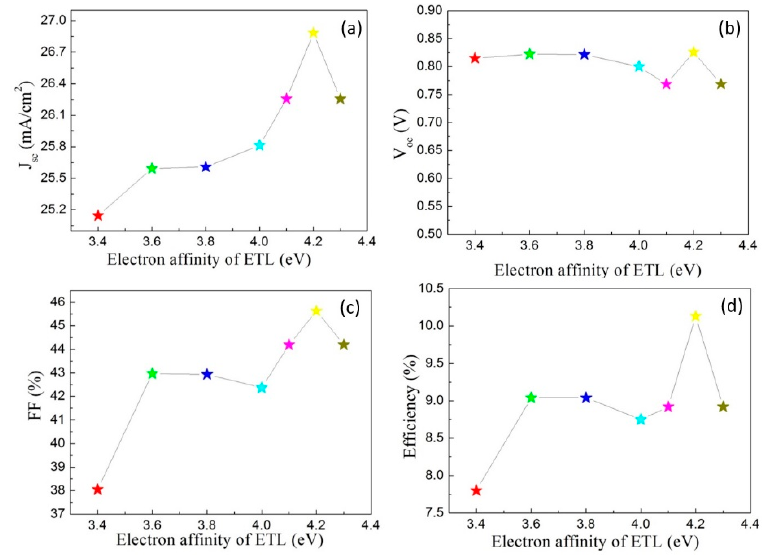
Figure 6. Effect of electron affinity of ETL on the ( a ) J sc , ( b ) V oc , ( c ) FF and ( d ) efficiency of the solar cell.